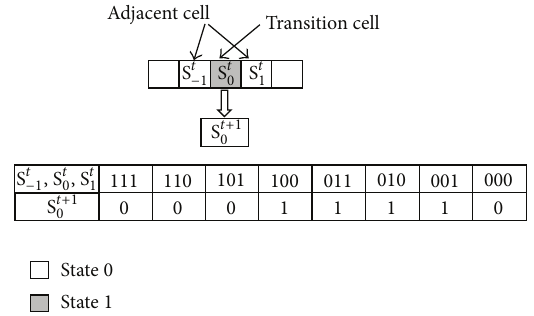
Figure 3: Example of the transition rule in the one-dimensional cellular automata system. The permutations of the state of three cells are 2 3 = 8 and the state of the next step is also dyadic (0 or 1). As a result, the transition pattern has 2 8 = 256